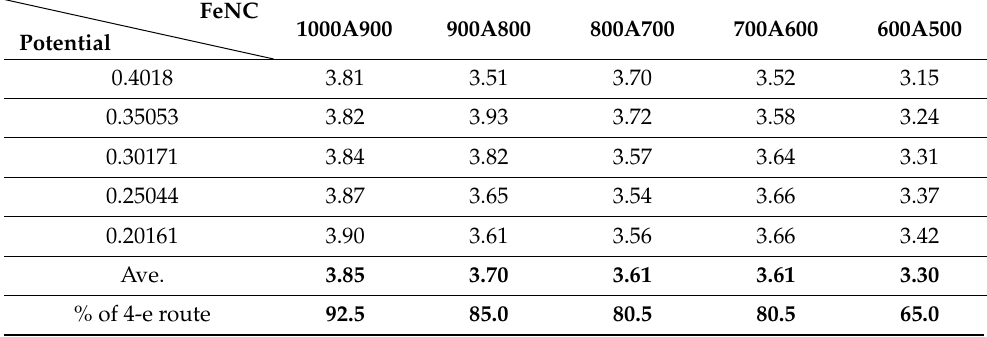
Table 4. Numbers of transferred electrons of various FeNCs.